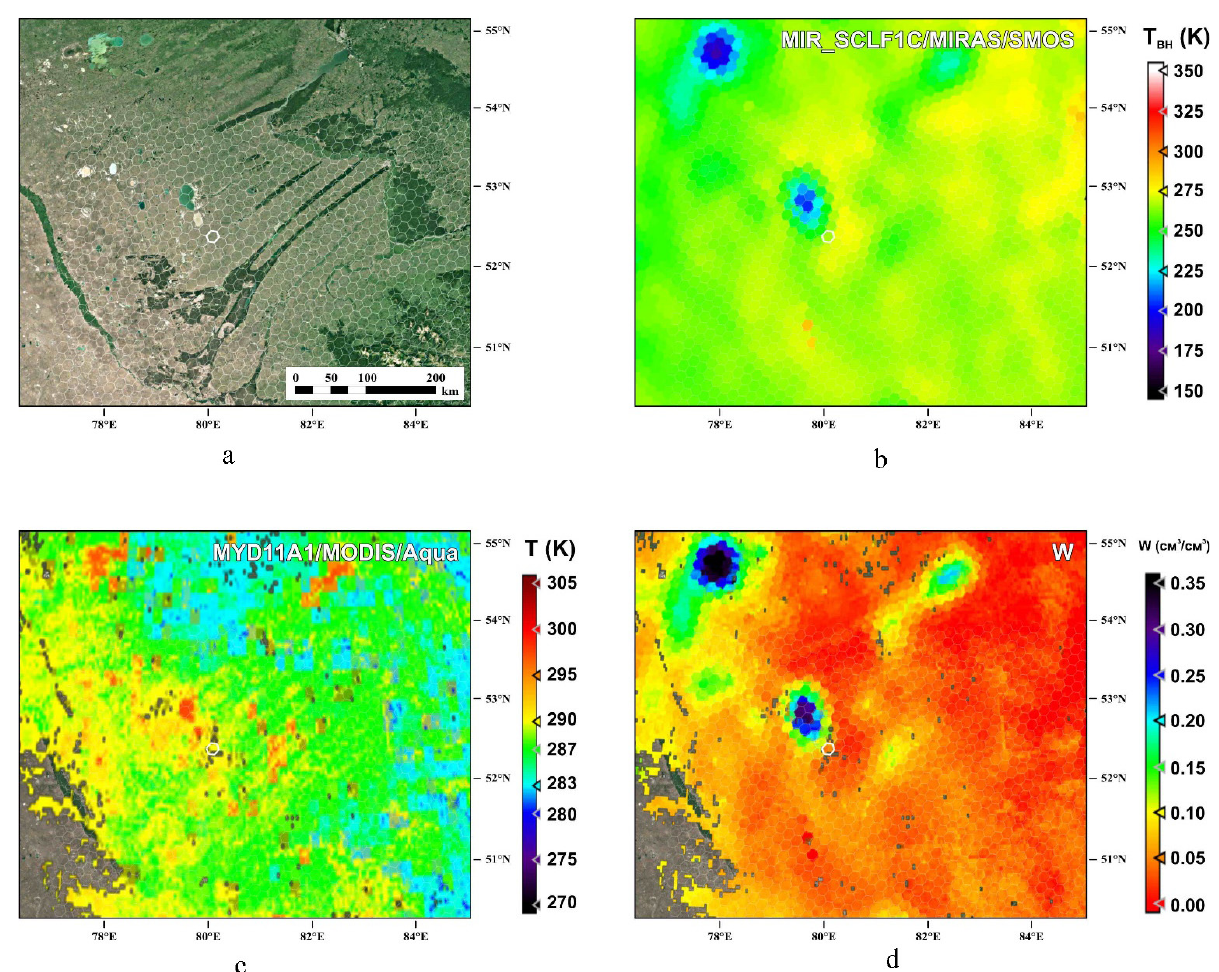
Figure 8. Seasonal dynamics of T BH , T and W, 1—brightness temperature T BH , 2—temperature T, 3— volume fraction of water in soil W: 4—periods of drought, 5—period of drought which ended with the declaration of a state of emergency.